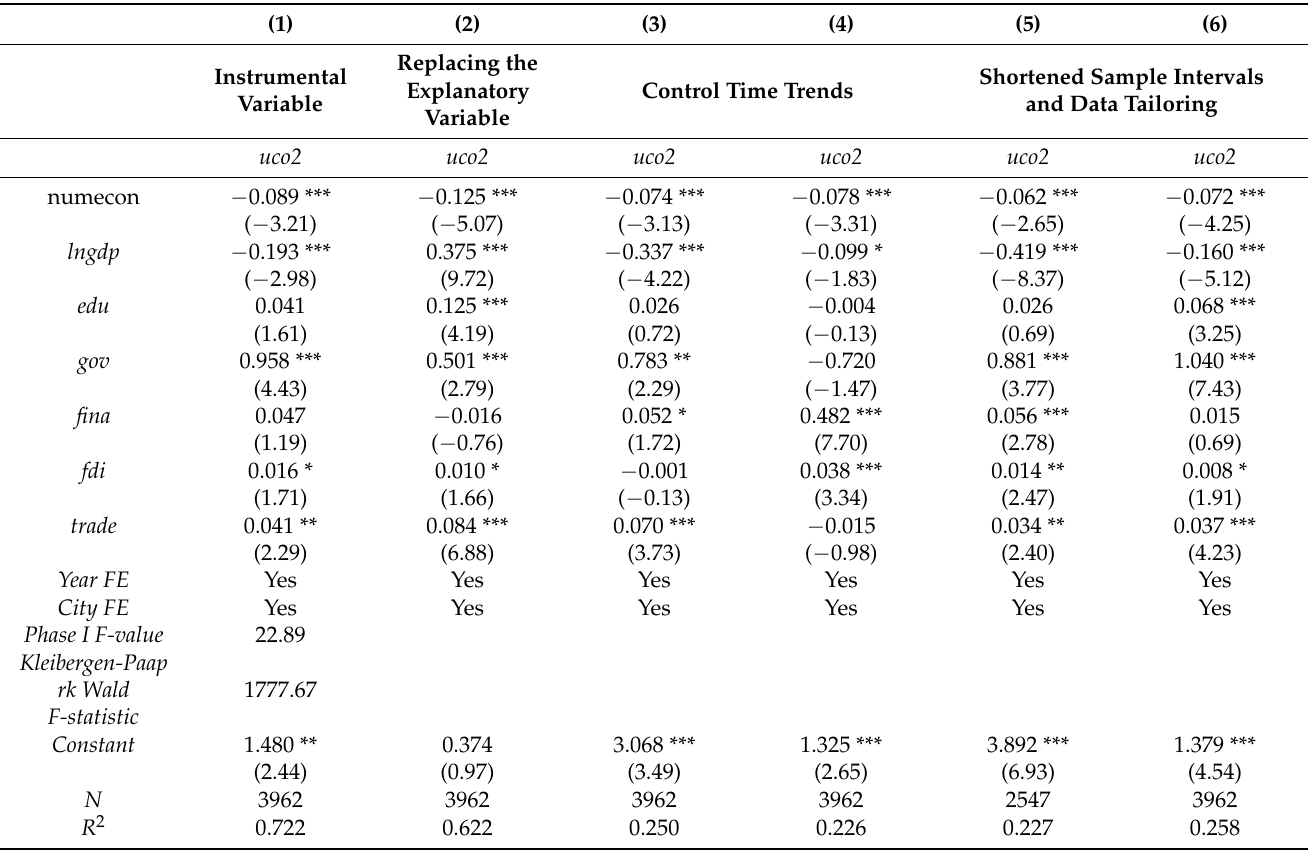
Table 4. Robustness tests for each